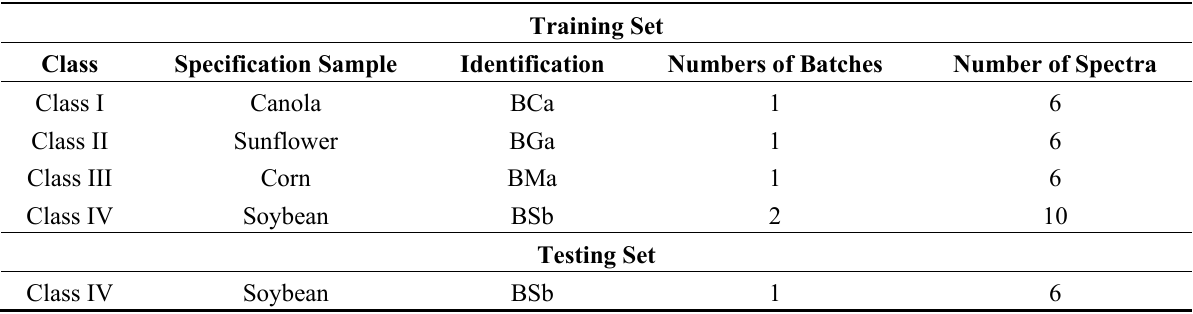
Table 1. Training and testing data sets of the SIMCA